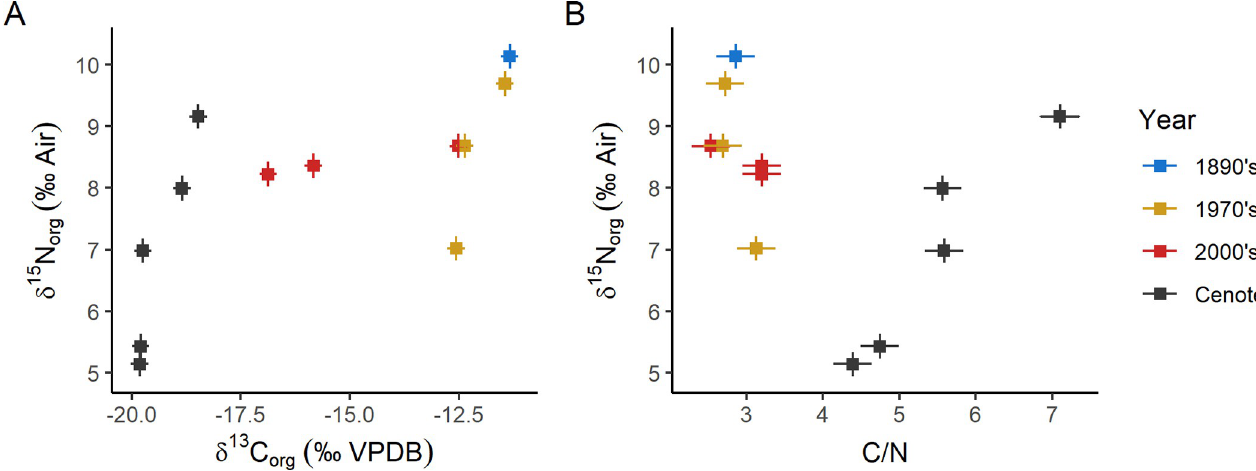
Fig 7. Isotope values of organic matter and the C/N ratio of the organic matter. Error bars are 2 standard deviation instrumental precision. A) δ 13 C org vs δ 15 N org , B) C/N vs δ 15 N org